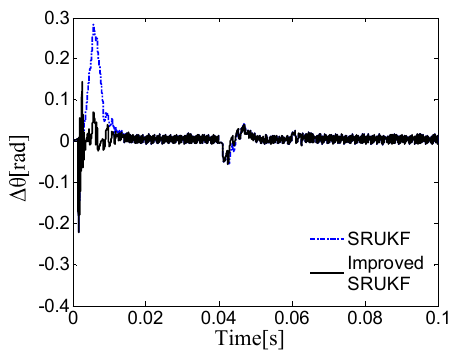
Figure 12. Space position estimation at load disturbance.